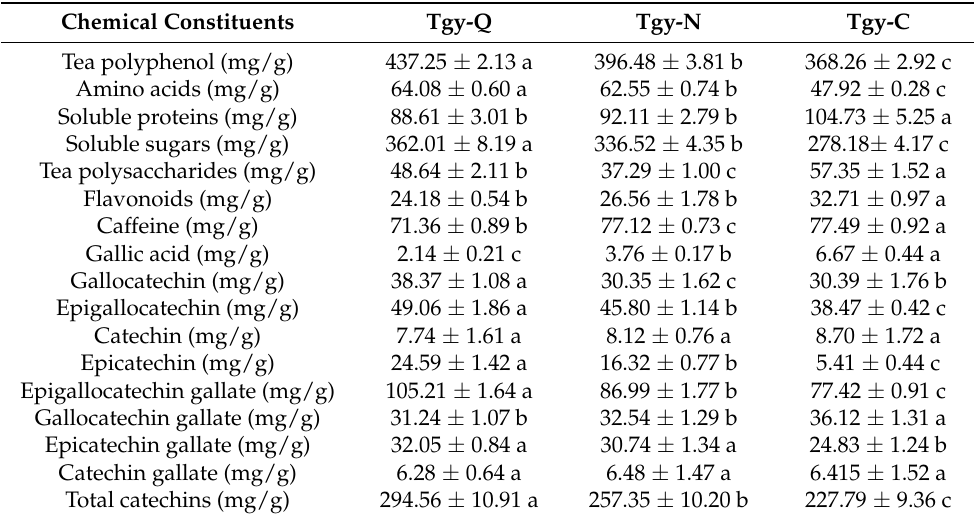
Data represent mean ± SD of three replicates. Different lowercase letters in the same row indicate significant differences between mean values ( p <